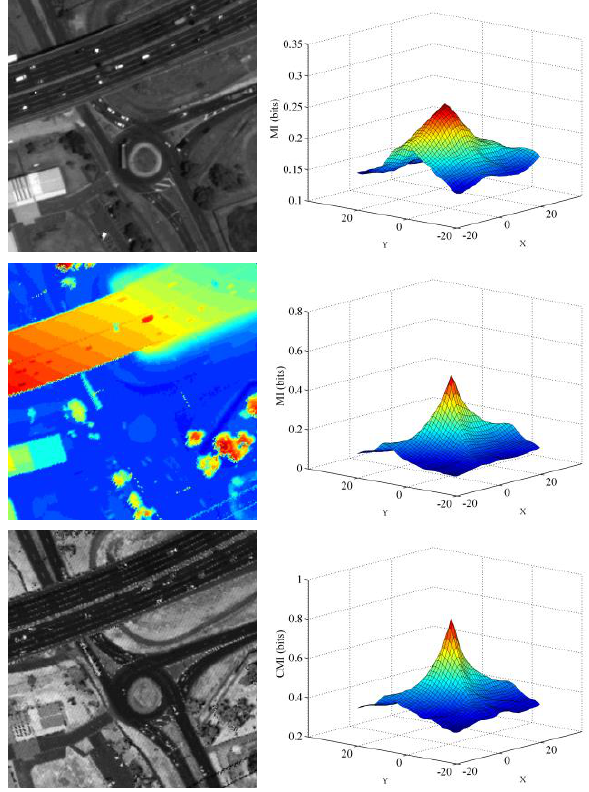
Figure 4. Satellite image, LiDAR DSM and intensity image (left column). Also, MI convergence surface of LiDAR DSM and intensity image and CMI convergence surface of image and LiDAR data for translation in x and y directions (right column).